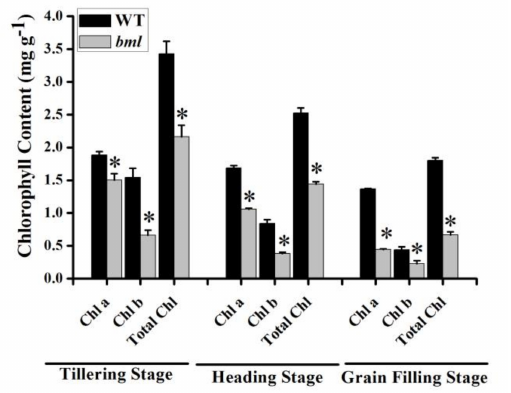
Figure 3. Photosynthetic pigment content analysis. Contents of the photosynthetic pigments in the leaves during the tillering, heading, and grain-filling stages in bml and WT. Chl: chlorophyll; Chl a: chlorophyll a; Chl b: chlorophyll b. All data are shown as means ± SD of five replicates; * p < 0.05 by Tukey’s